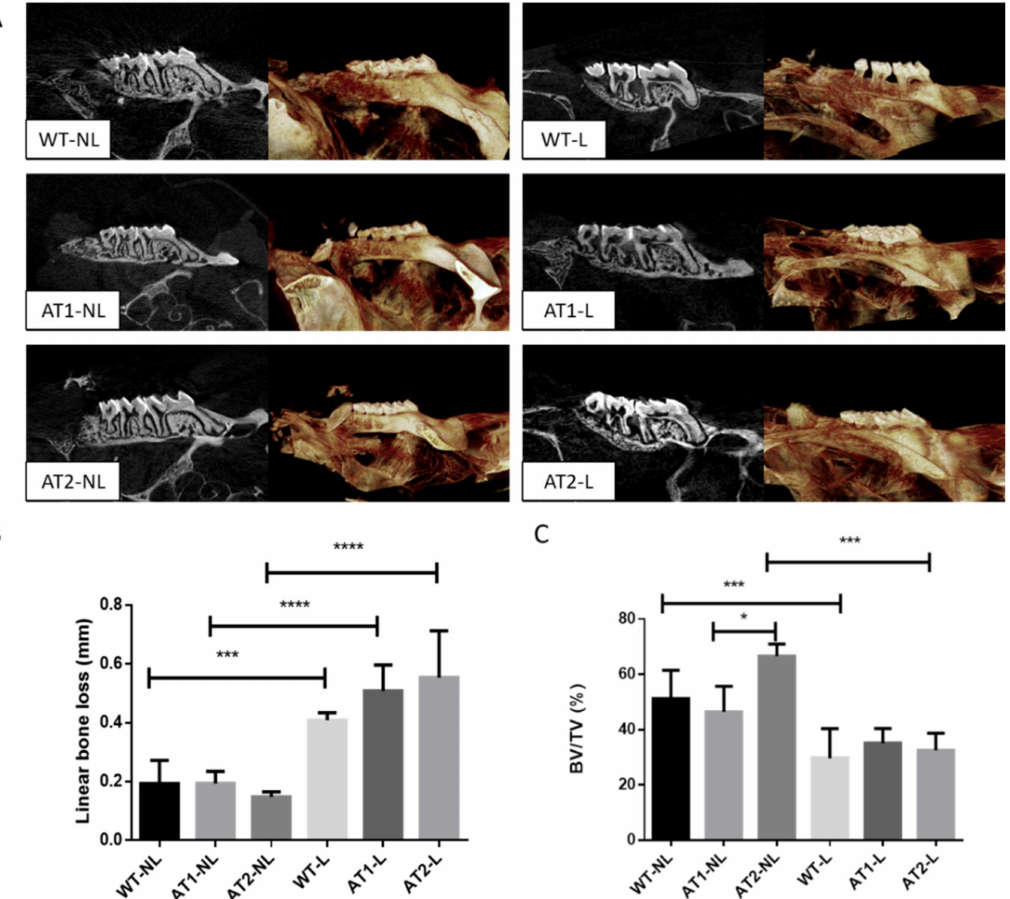
Figure 1. Micro-CT. ( A ) 3D reconstruction and 2D image of the maxilla of healthy and ligation-induced periodontal disease animals; ( B ) linear bone loss results; ( C ) bone volume ratio results. Mean and standard deviation. Statistical differences by brackets labeled by * p < 0.05, *** p < 0.001, **** p < 0.0001 comparing WT-NL vs. WT-L, AT1-NL vs. AT1-L, AT2-NL vs. AT2-L, AT1-NL vs. AT2-NL, AT1-L vs. AT2-L, WT-L vs. AT1-L. (Graph Pad Prism 6.01 software). n = 5 animal per